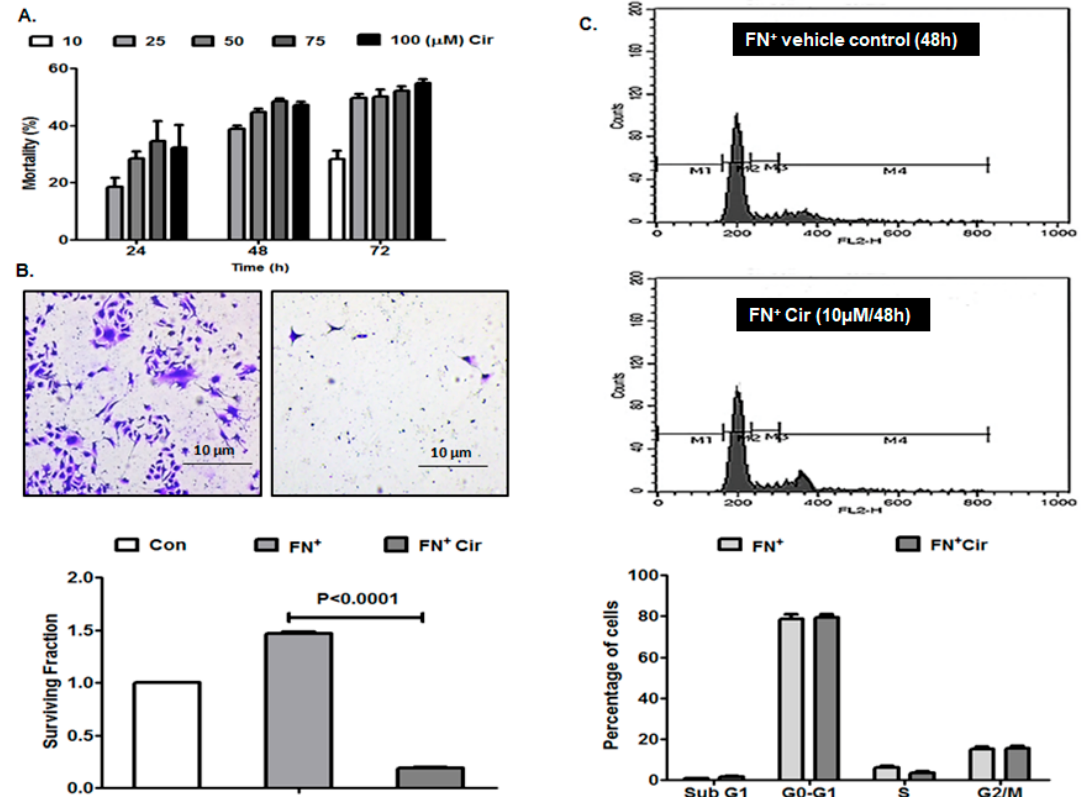
Figure 1. Effects of cirsiliol on cell mortality, colony formation and cell cycle of B16F10 cells. ( A ) Concentration- and time-dependent cytotoxic effect of cirsiliol. ( B ) Colony formation assay micrographs (400× magnification) and graphical representation of significant inhibition of surviving fraction in fibronectin (FN + ) and cirsiliol (Cir) [10 µM/48 h]-treated cells compared to cells exposed to FN only. ( C ) No significant alteration of percentage of cells in different phases of cell cycle was observed between FN + /Cir (10 µM/48 h) cells and FN-induced cells treated with vehicle as depicted by representative figure and graph. All quantitative results are expressed as mean±standard deviation (SD) based on three replicates. M1: Sub G1; M2: G0-G1; M3: S; and M4: G2/M.